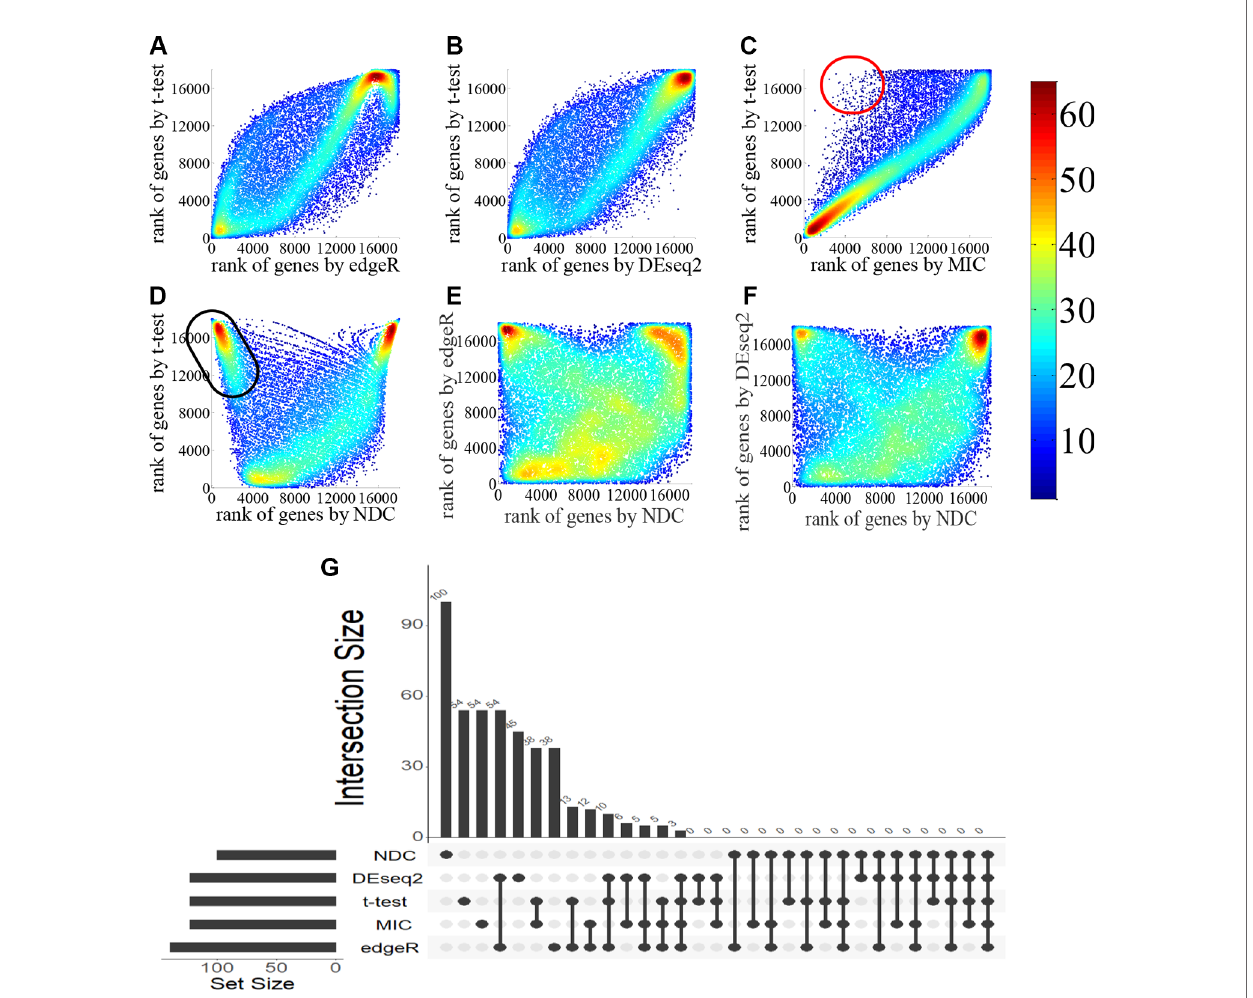
FIGURE 2 | Comparison of gene ranking by t -test, edgeR, DEseq2, maximal information coef fi cient (MIC), and normalized differential correlation (NDC) for the lung squamous cell carcinoma (LUSC) dataset. In (A – F) : the color indicating data density; The red and black circles are just approximate region to visualize that, there are some genes can be highlighted by DNC methods, but cannot be highlighted by t-test. (G) overlaps of the top 100 genes selected by fi ve